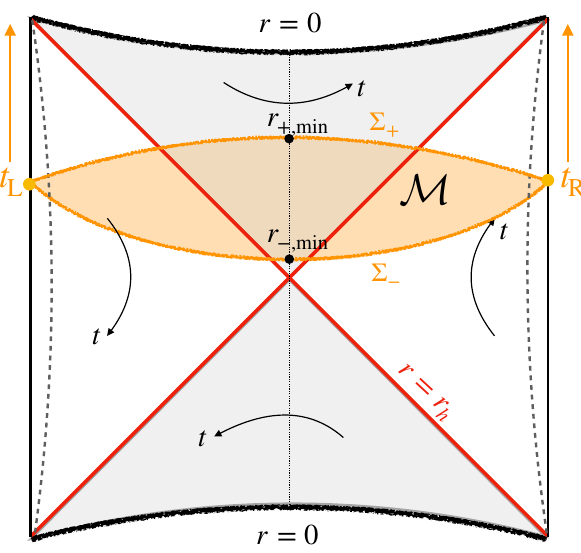
Figure 1 . The codimension-zero region M (orange shaded patch) illustrated in an eternal AdS black hole background. The future and past boundaries of M are denoted by Σ are both anchored on the same boundary time slice Σ